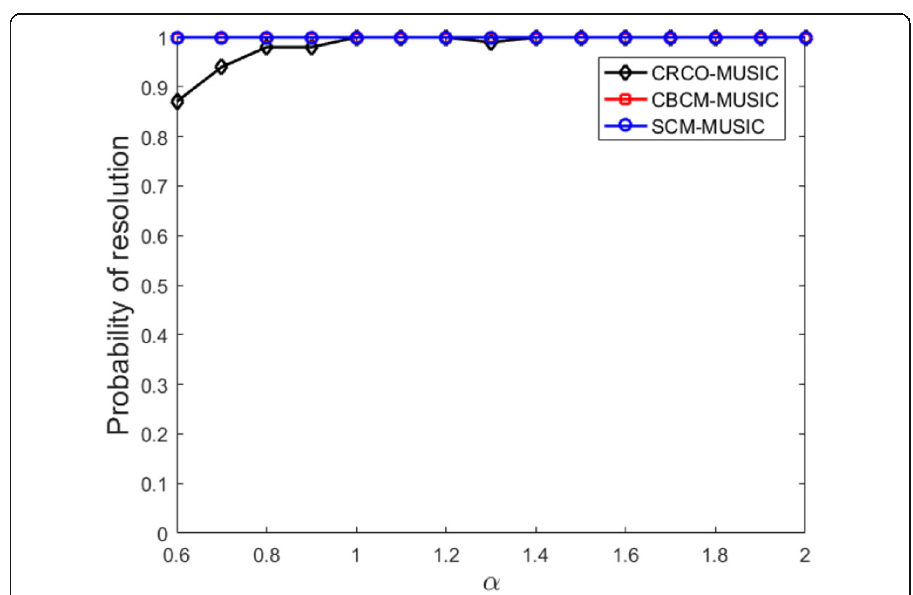
Fig. 18 Probability of resolution against characteristic exponent